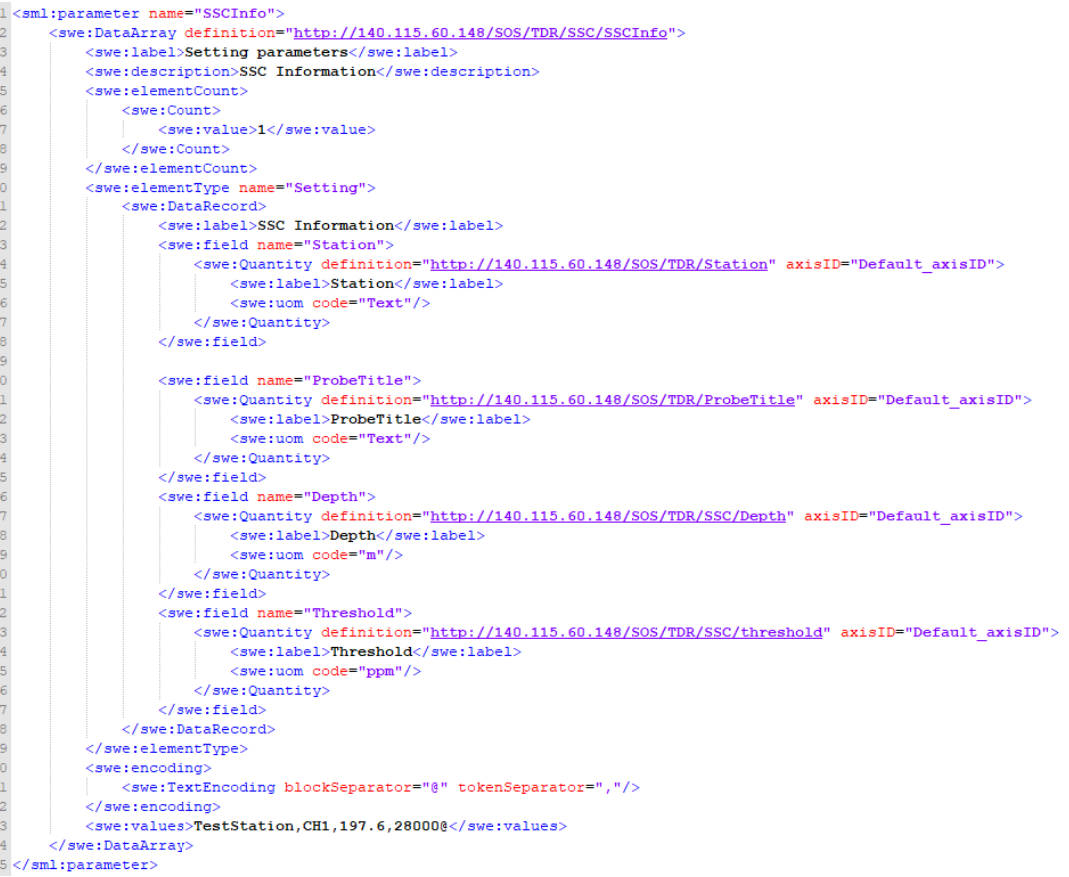
Figure 13. Insert sensor XML request of InsertSensor_SSCInfo.